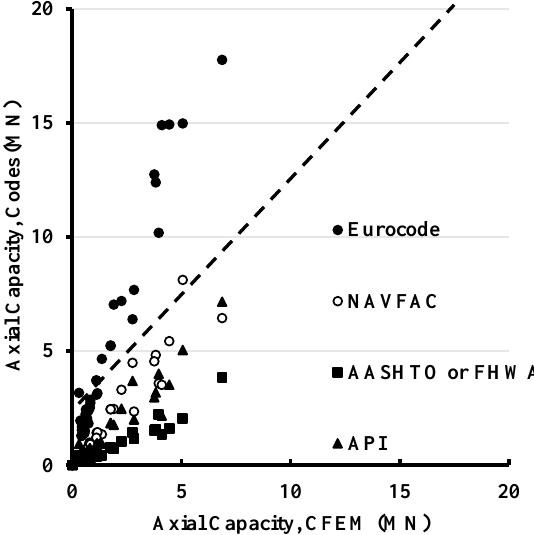
Figure 3. Comparison between results of other design codes and the theoretical axial capacity in drilled (bored) piles determined using the CFEM.